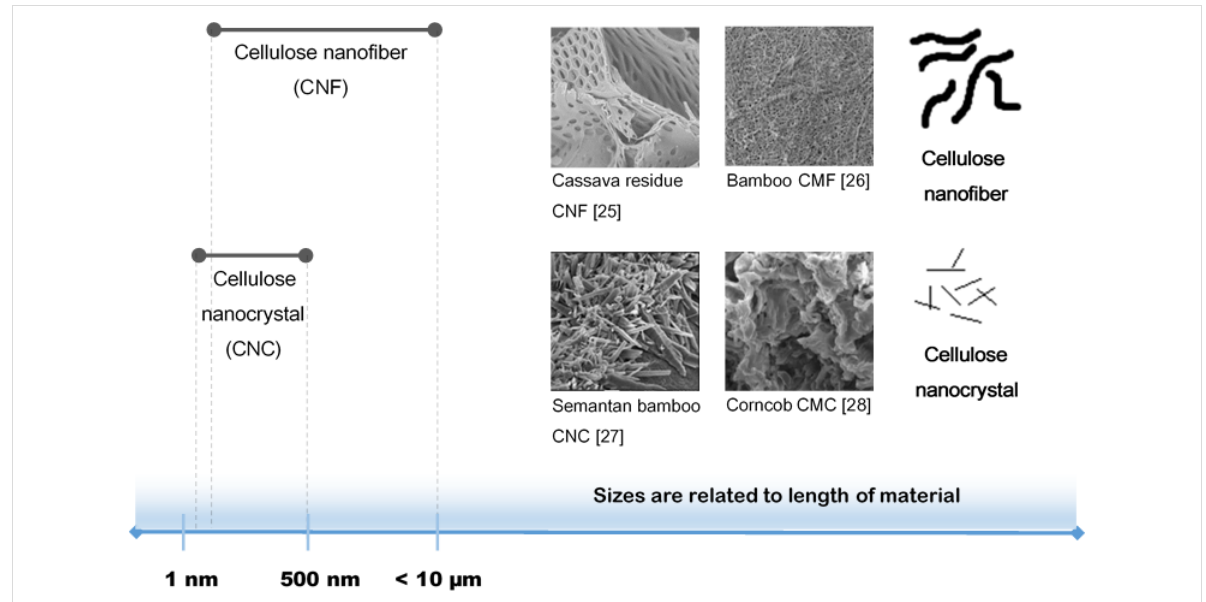
Figure 1: Size chart of nanocellulose based on material length (with microscopic images of various nanocellulose sources). Reprinted in part from Huang et al. [25], Nguyen et al. [26], Razalli et al. [27], and Kunusa et al. [28].